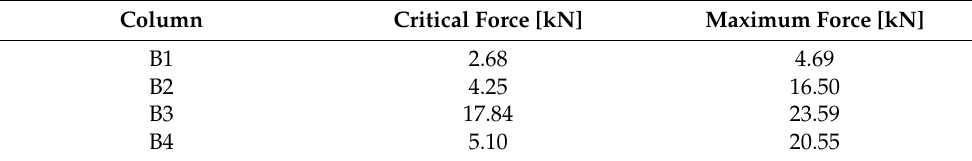
Table 4. Values of critical and maximum forces determined from strain gauges